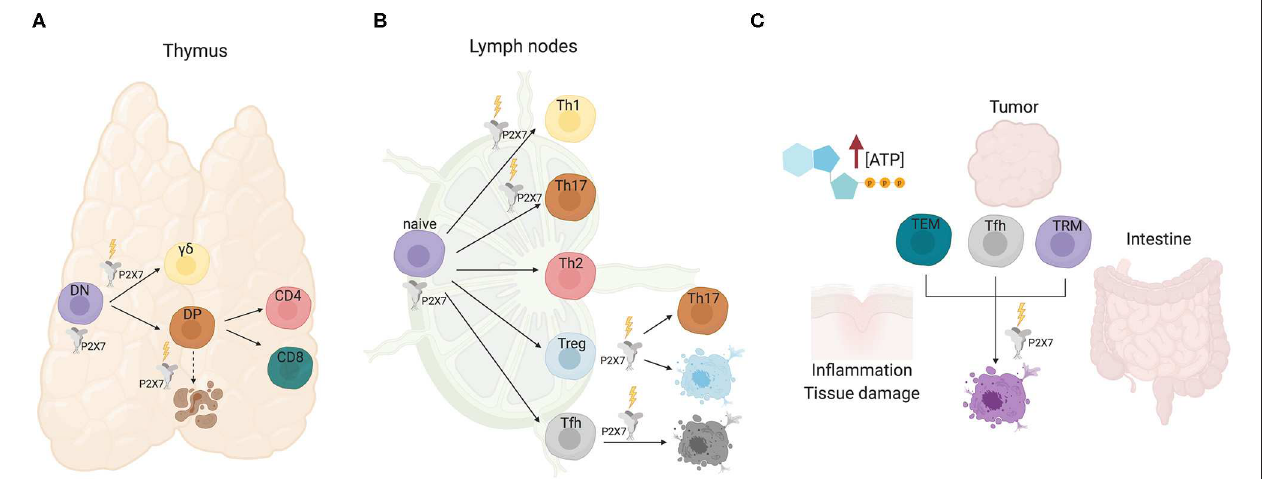
FIGURE 1 | P2X7 activity in T cell development and function. (A) In the thymus, P2X7 activity could promote differentiation of immature DN cells. Signaling by P2X7 contributes to γδ lineage choice by promoting ERK phosphorylation and induction of early growth response ( Egr ) transcripts. Conversely, progression to the DP and single positive CD4 or CD8 stages is not influenced by P2X7, albeit P2X7 might function in cell death induction of neglected DP cells. (B) In secondary lymphoid organs, P2X7 stimulation promotes Th1/Th17 polarization of CD4 + naïve cells, Tregs conversion to Th17 cells and cell death of Tfh cells that are not stimulated by cognate antigen. (C) Sensitivity of TEM, Tfh, and tissue resident memory T cells to P2X7 mediated cell death in eATP rich microenvironments.